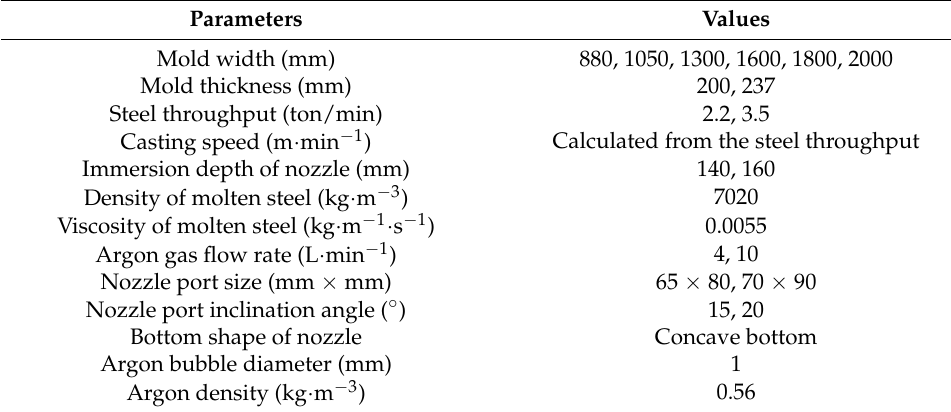
Table 1. Experiment and simulation parameters.